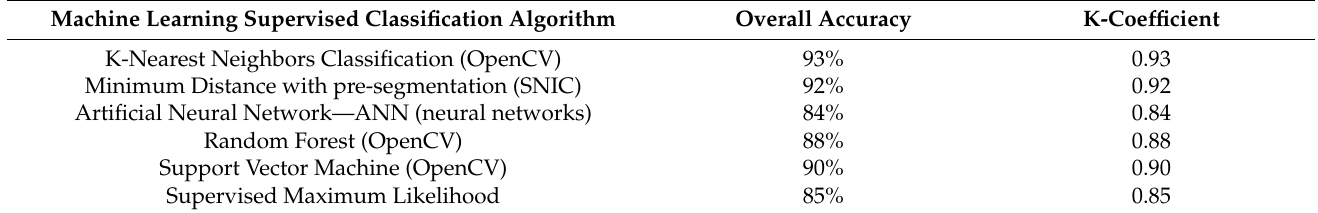
Table 8. Accuracies obtained from different machine learning algorithms to perform supervised classifications.